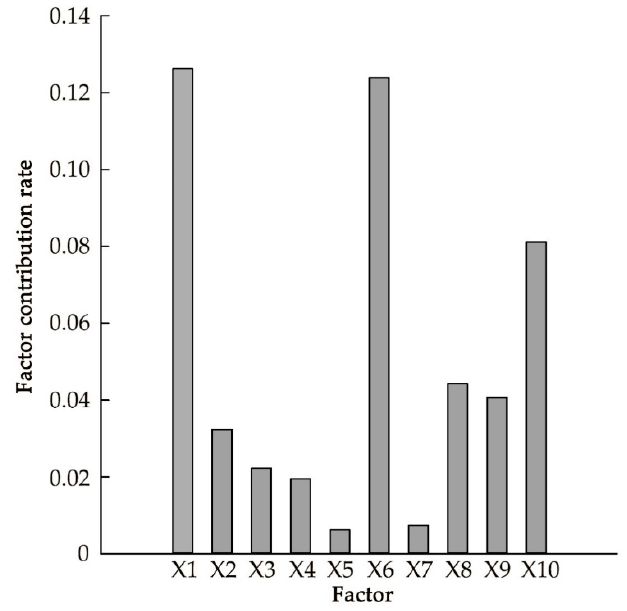
Figure 6. Influence of the driving factors.